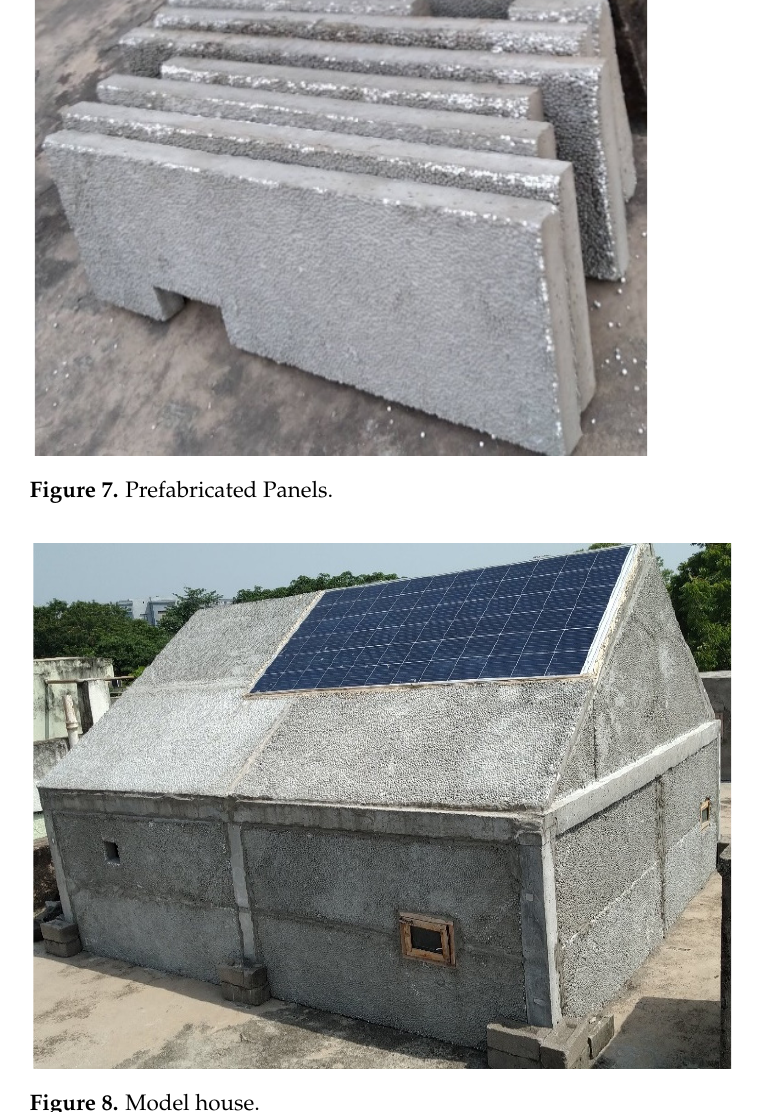
Figure 8. Model house.